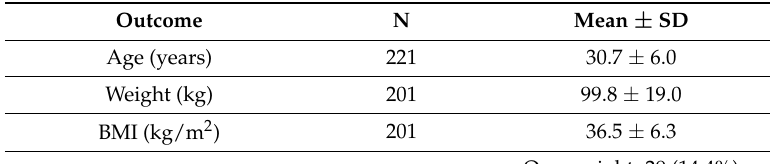
Table 1. Characteristics of study participants.